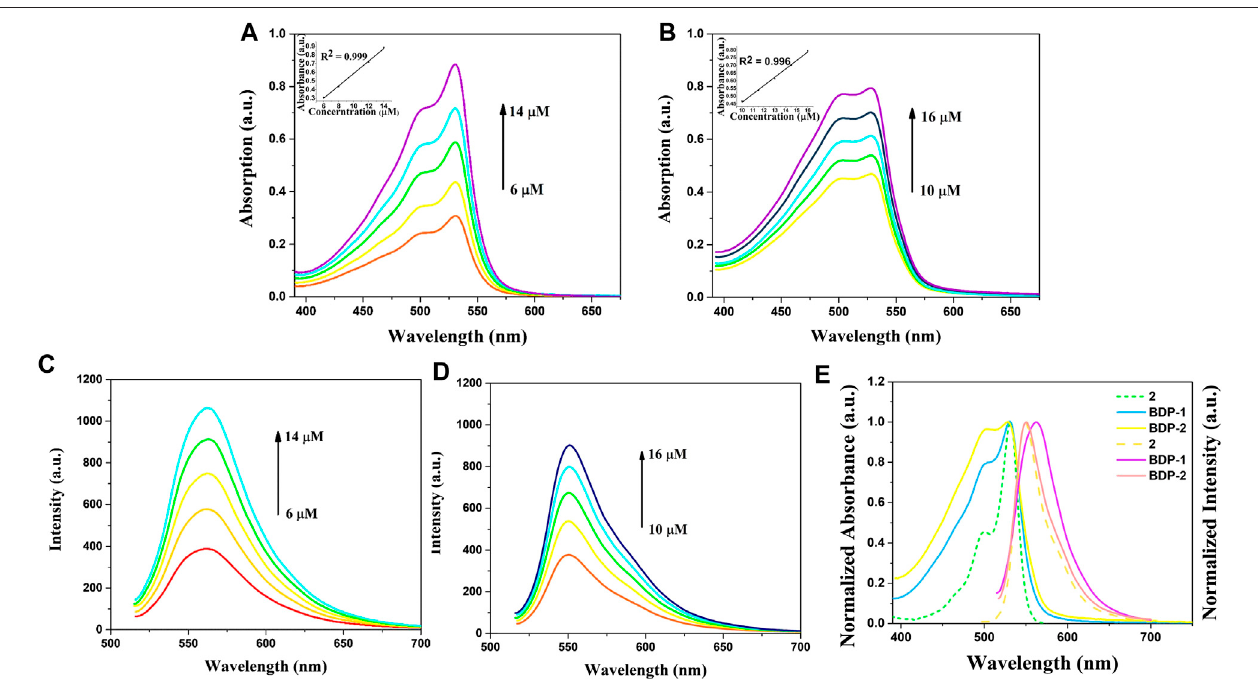
FIGURE 1 | Absorption and emission spectra of BDP-1 and BDP-2. Absorption spectra of (A) BDP-1 and (B) BDP-2 in methanol at 25 ° C. Emission spectra of (C) BDP-1 and (D) BDP-2 in methanol at 25 ° C. (concentration BDP-1: 6, 8, 10, 12, 14 μ M; BDP-2: 10, 11.5, 13, 14.5, 16 μ M). (E) Normalized spectrum of 2, BDP-1 and BDP-2. Insert: The absorption changes upon the increasing concentration.